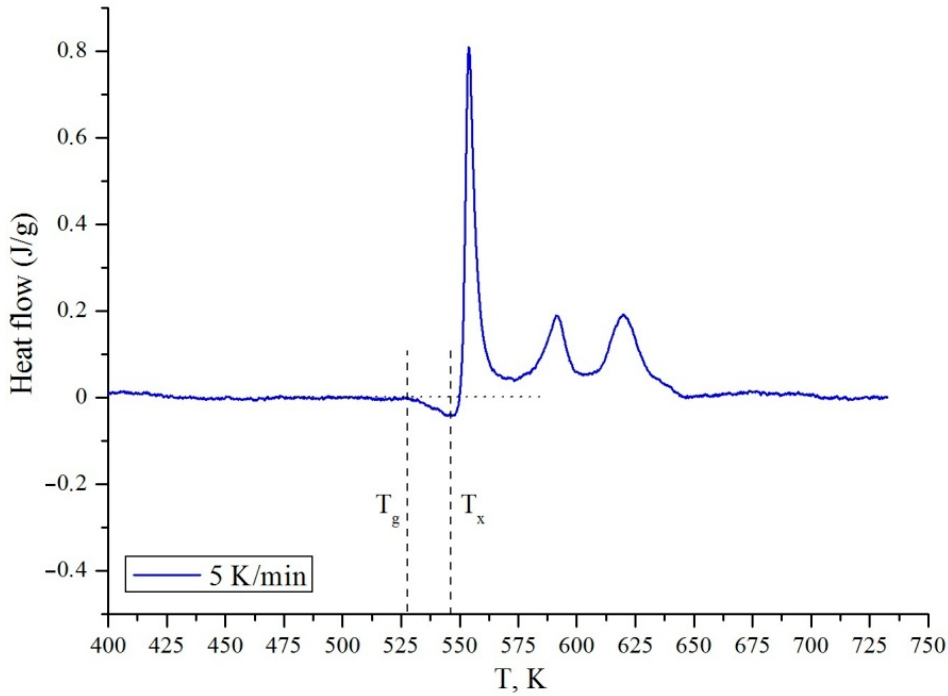
Figure 1. Thermogram of Al 85 Y 8 Ni 5 Co 2 glassy alloy. All specimens have amorphous structure that was confirmed with X-ray diffractometry (Figure 2). When tested under the cyclic load, the specimen elongates at a higher velocity com- pared to that at the constant load. The increase in the oscillation frequency from 0.3 to 3 Hz leads to a further increase in the deformation velocity of the